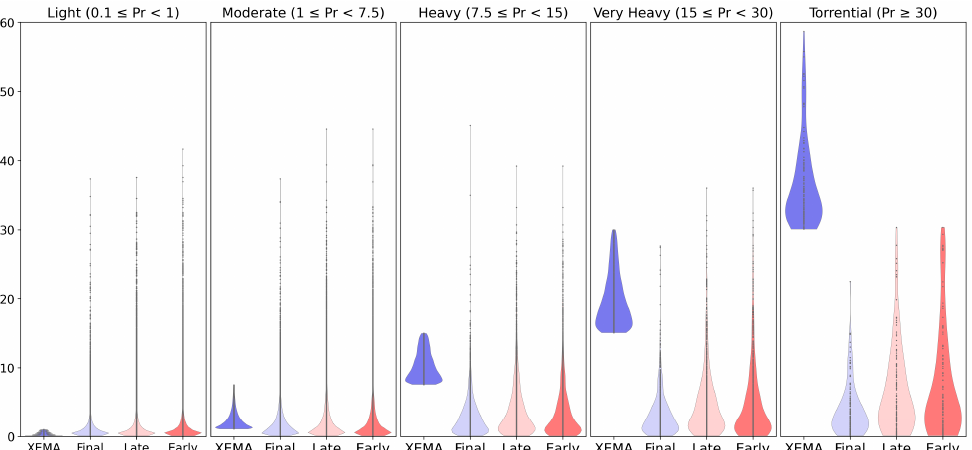
Figure 10. Violin plots of half-hourly rain gauge observations (XEMA) and IMERG products for the five rainfall intensity classes considered. Rainfall rate thresholds are given in mm/30 min.